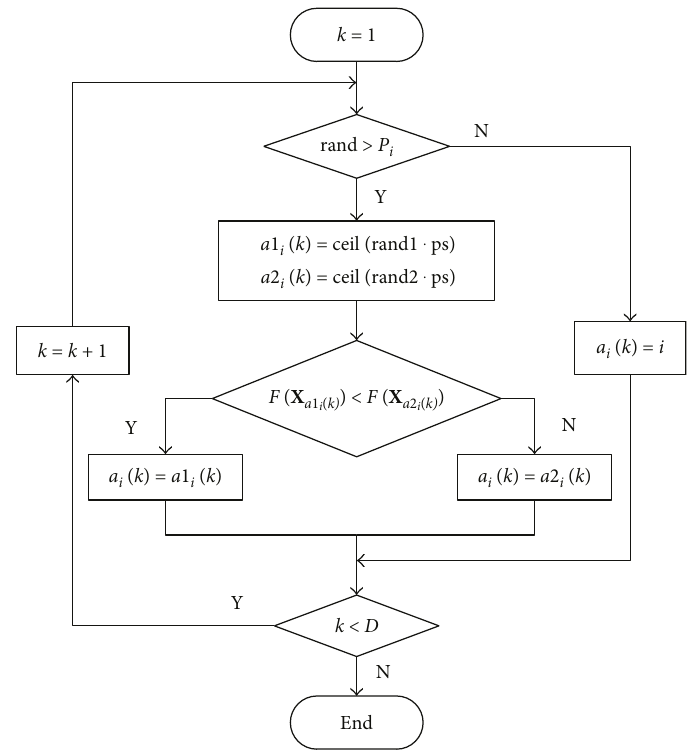
Figure 3: Selection procedure of auxiliary mutation individuals for the fi rework X